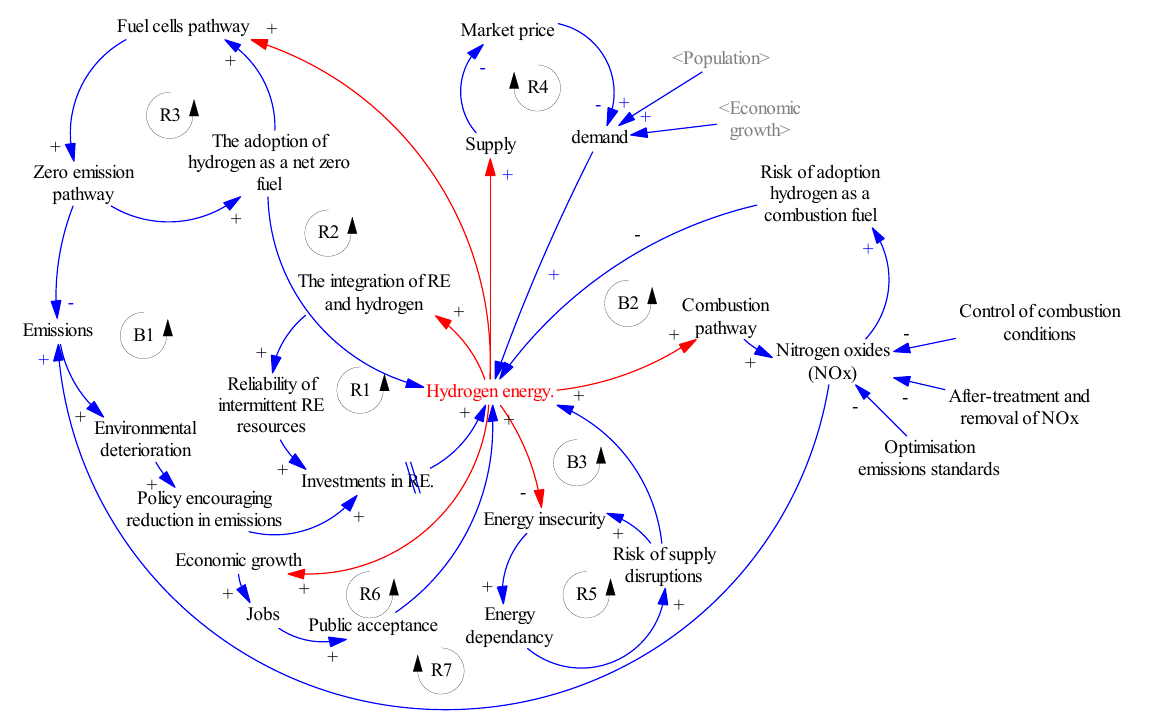
Figure 5. The CLD of hydrogen energy. A positive polarity (+) means that the two variables change in the same direction, while a negative polarity (-) means that they move in the opposite direction. Double bars (||) indicate a time delay between the two variables. R represents Reinforcing loops, while B represents Balancing loops. Table 2. The feedback loops within Figure 5.